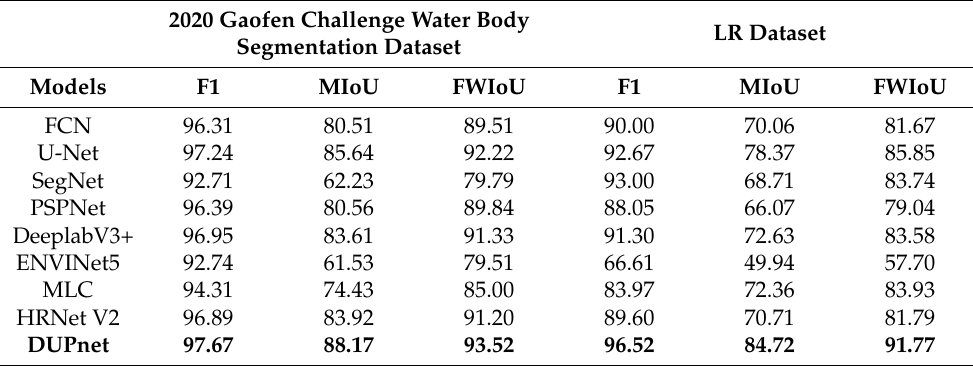
Table 6. Quantitative comparison of different models in terms of F1, MIoU, and FWIoU (%) on the 2020 Gaofen challenge water body segmentation dataset and the LR